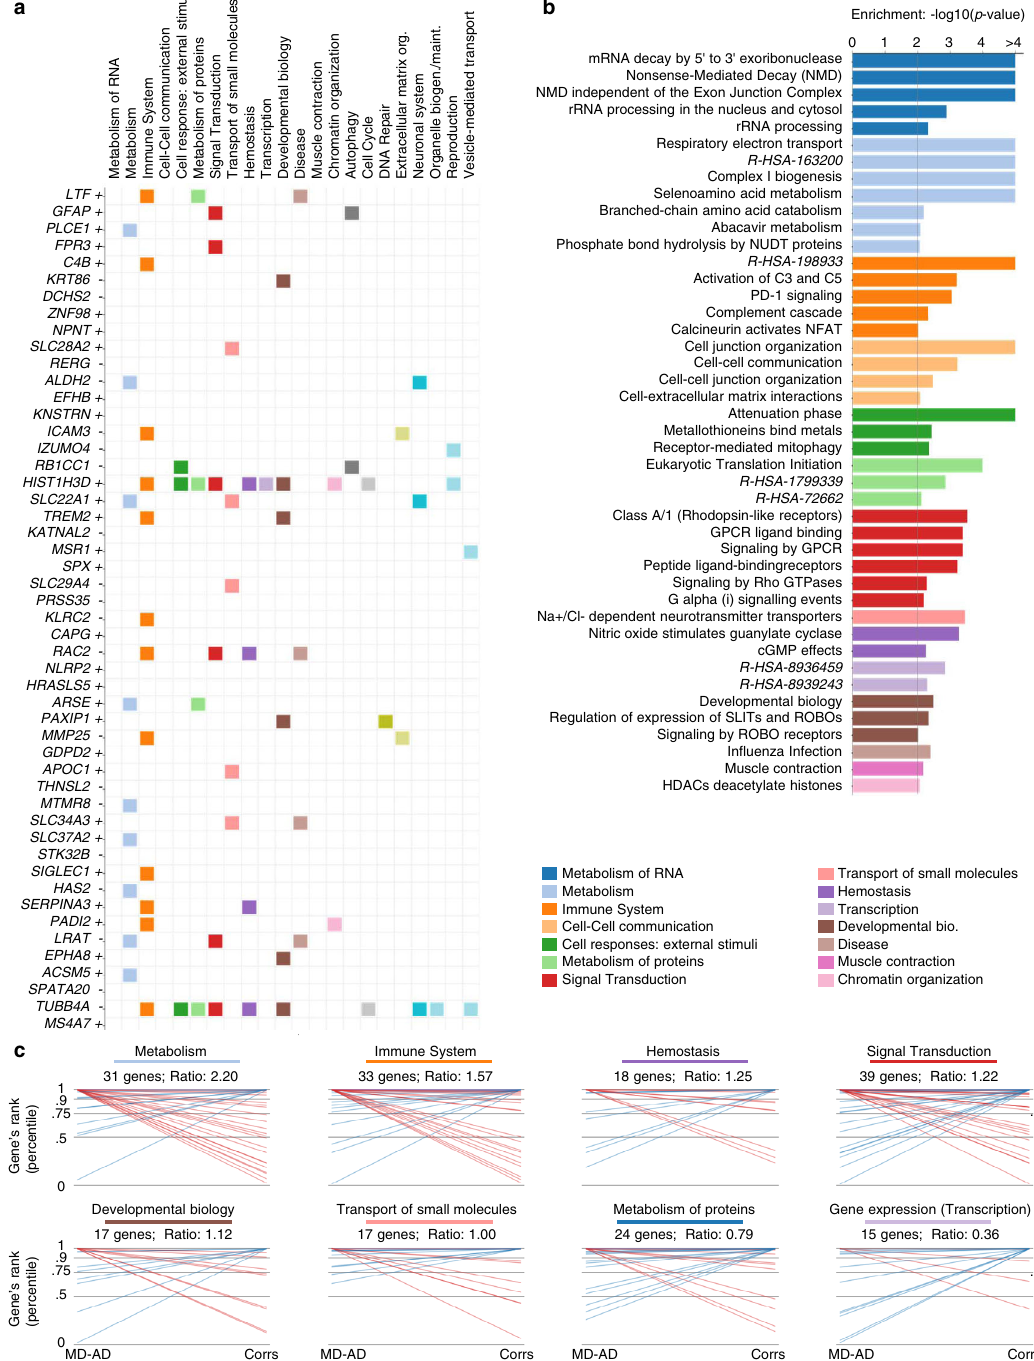
Fig. 4 Top predictive genes for the consensus MD-AD model. a Top 50 MD-AD genes and whether they are negatively ( − ) or positively ( + ) associated with high neuropathology. Colored squares indicate that the gene belongs to at least one pathway in the column-labeled REACTOME category. b Gene set enrichment − log10( p value) across the fi nal MD-AD gene ranking for REACTOME pathways. Bars are colored by the pathway ’ s REACTOME category. We show all pathways with signi fi cant enrichment ( p < 0.01). REACTOME pathways with long names are indicated by their REACTOME stable IDs. c Comparison of top genes from MD-AD vs a linear correlation-based approach. For each ranking method, we identify the top 1% of all genes and check their membership in REACTOME categories. For each REACTOME category with at least 15 genes in the top 1% of MD-AD and/or correlation rankings, we generate the following plot: each line represents a gene, with the left endpoint at the percentile rank for MD-AD and right endpoint at percentile rank for correlations. For clarity, we color the line purple if the gene falls in the top 1% of both MD-AD and correlations, red if it is only in the top 1% of MD-AD, and blue if it is only in the top 1% of correlations. Finally, the title indicates the ratio of MD-AD to correlation-based top genes for the given REACTOME